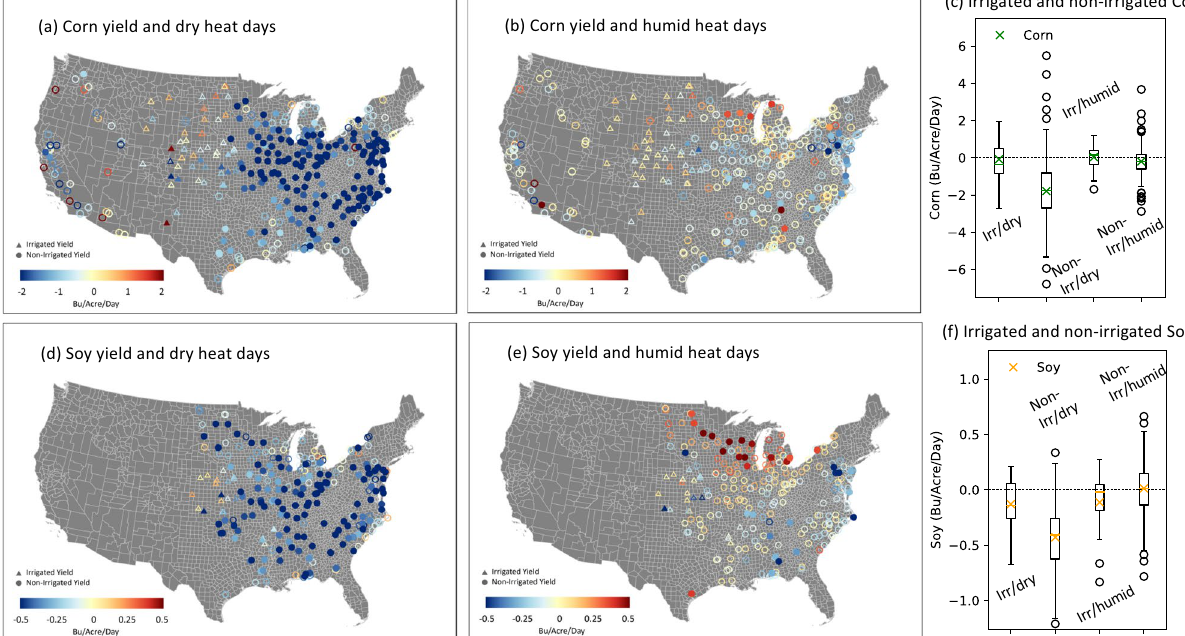
Figure 3. Multiple regression coefficients between crop yields and dry and humid heat days for all the counties with crop yield data. ( a , b , d , e ) Multiple regression coefficients between detrended corn ( a , b ) yields with detrended extreme dry ( a ) and humid ( b ) heat days (using the 95th percentile threshold) in bushels per acre per one heat day exposure for the period 1979–2019. ( d ) and ( e ) are the same as ( a ) and ( b ) but for detrended soybean yields. Significant values using a two-sided Student t-test at the 5% significance level are indicated in solid filled circles and triangles and non-significant values in open ones. Circles indicate non-irrigated yields and triangles indicate irrigated yield. ( c and f ) Box plots showing the interquartile range (boxes) and the data range (solid vertical lines, whiskers) of the regression coefficients for irrigated yields with dry heat (Irr/dry), non-irrigated yields with dry heat (Non-Irr/dry), irrigated yields with humid heat (Irr/humid) and non-irrigated yields with humid heat (Non-Irr/humid) for corn ( c ) and soy ( f ). The cross and horizontal line inside the box indicate the mean and median of the regression coefficients, respectively, and open circles in ( c ) and ( f ) indicate outliers. The maps are made with ArcGIS Pro 2.2.0 with the US base map downloaded from Census